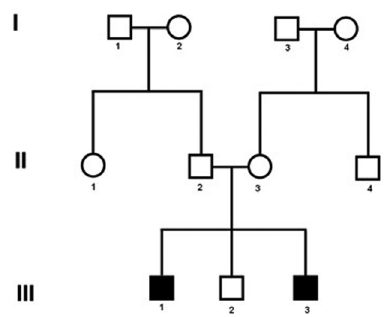
Figure 1 Pedigree showing the two cases with Alström Syndro- me (case 1: III-1 and case 2: III-3).